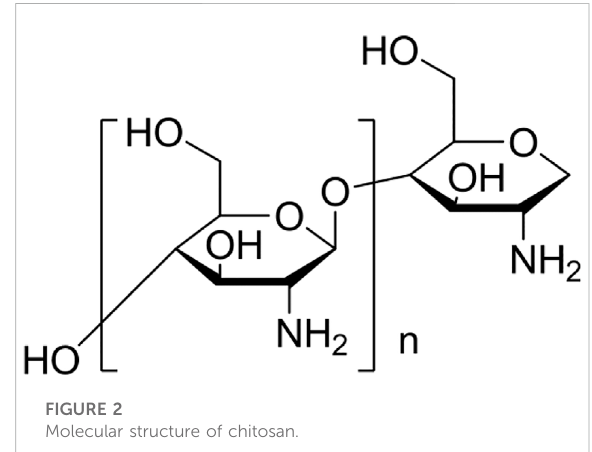
FIGURE 2 Molecular structure of